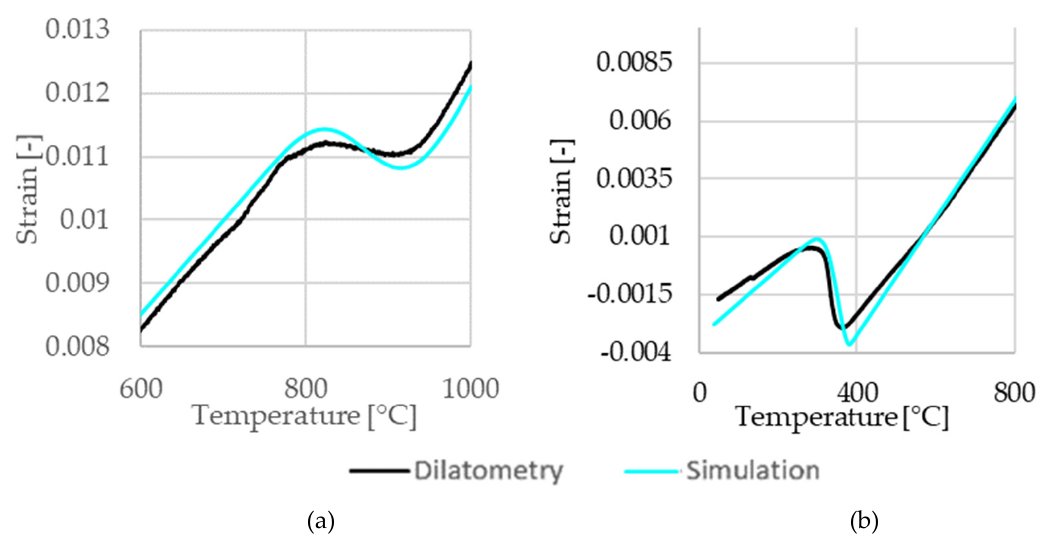
Figure 4. Comparison of the dilatometer measurements with the model predictions (Sim) for ( a ) heating at 400 °C/s and ( b ) cooling at 100 °C/s.